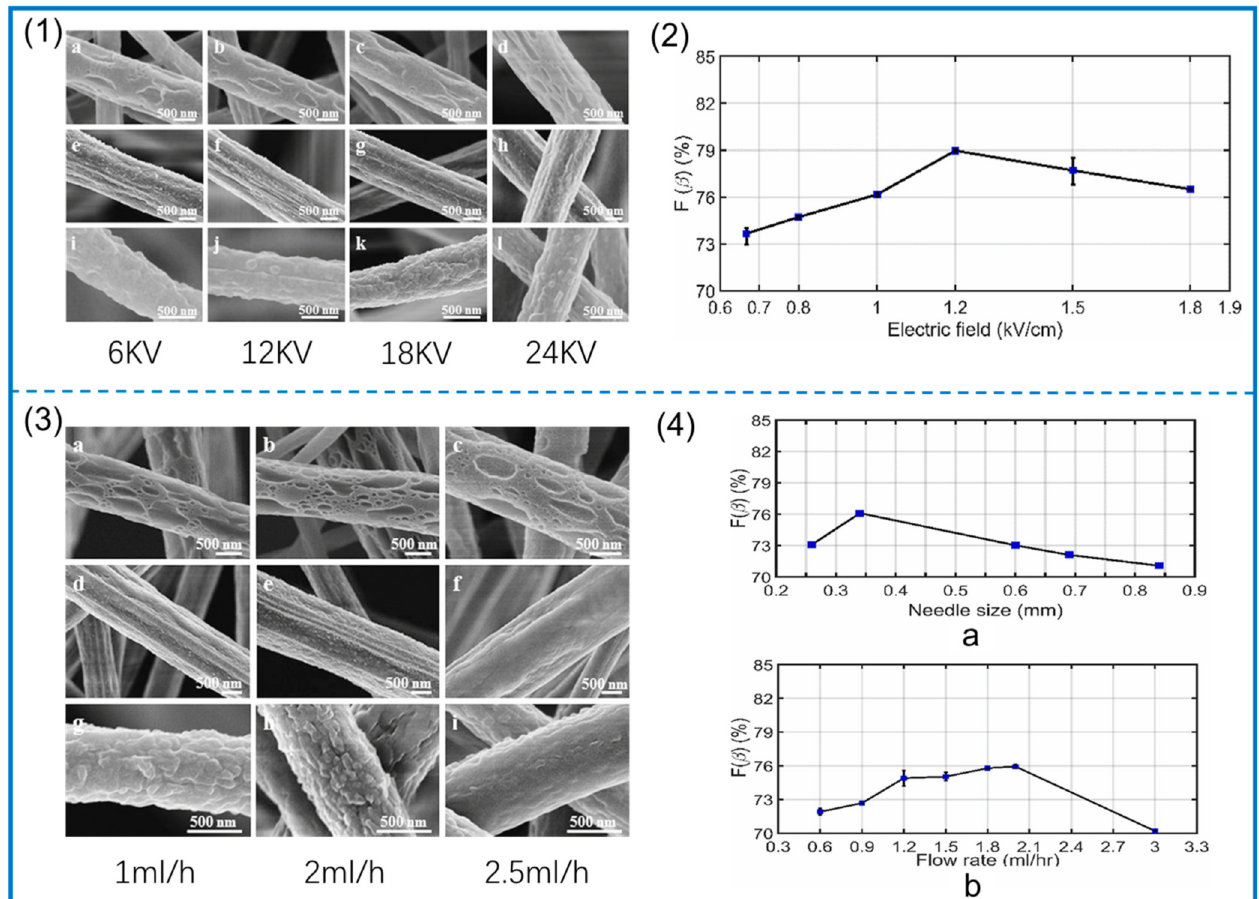
Figure 4. ( 1 ) SEM images of surface morphology of electrospun PVDF fibers under different applied voltage levels ( a , e , i ) 6 kV; ( b , f , j ) 12 kV; ( c , g , k ) 18 kV; ( d , h , l ) 24 kV. Reprinted with permission from Ref. [86], copyright 2019, IOP Publishing. ( 2 ) curves of percentage of β phase in PVDF NFs and voltage values of 10, 12, 15, 18, 22.5, and 27 kV. Reprinted with permission from Ref. [88], copyright 2021, Polymer. ( 3 ) SEM images of surface morphology of electrospun PVDF fibers at different flow rates ( a , d , g ) 1 mL/h; ( b , e , h ) 2 mL/h; ( c , f , i ) 2.5 mL/h. Reprinted with permission from Ref. [86], copyright 2019, IOP Publishing. ( 4 ) ( a ) Relationship between the proportion of β phase of PVDF NFs and the size of the needle eye (flow rate 2.0 mL/h). ( b ) Relationship between the percentage of β phase and the flow rate of solution (needle diameter 0.6 mm). Reprinted with permission from Ref. [88], copyright 2021,